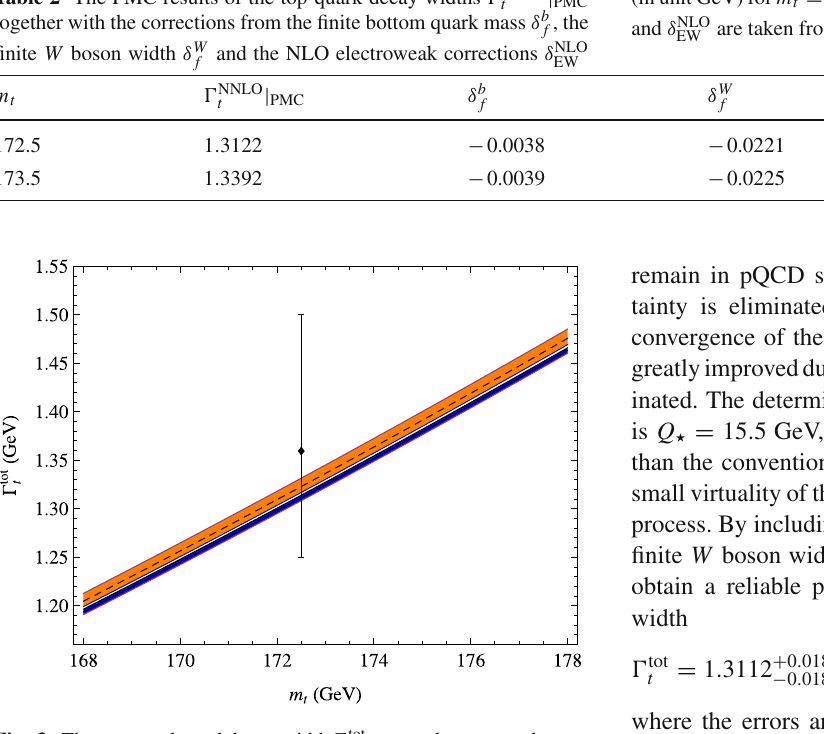
Fig. 3 The top-quark total decay width (cid:5) tot t versus the top-quark mass m t , where the solid line and the blue band represent the PMC predic- tions and the dashed line and the orange band stand for the conventional predictions. As a comparison, the most precise experimental measure- ments [28] is also